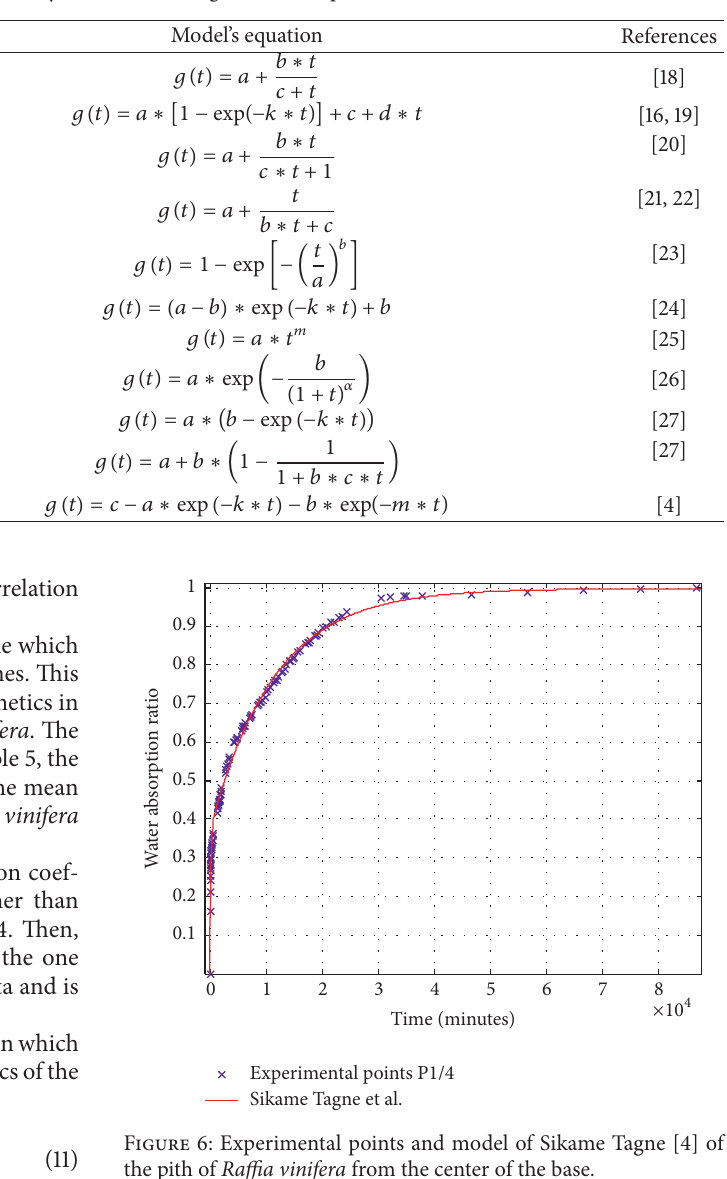
Table 3: Utilized models summary for the modelling of the absorption kinetics.